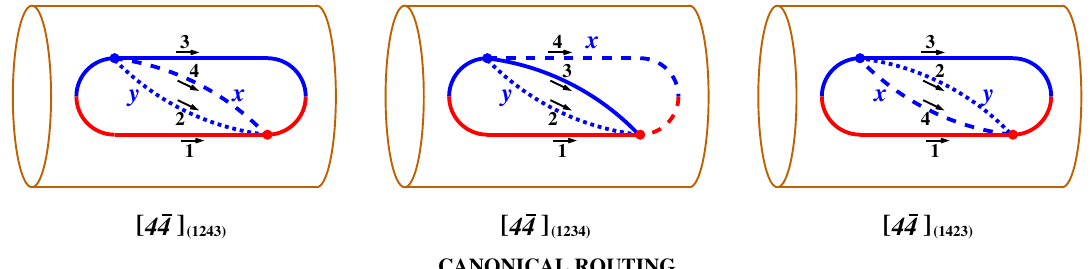
Figure 13 . The three large- N c color routings of the 4¯4 diagram, drawn with the same conventions as figure 10 except that here we have not bothered to shade the region of 4-particle evolution. (This figure is adapted from figure 14 of ref. [16].).